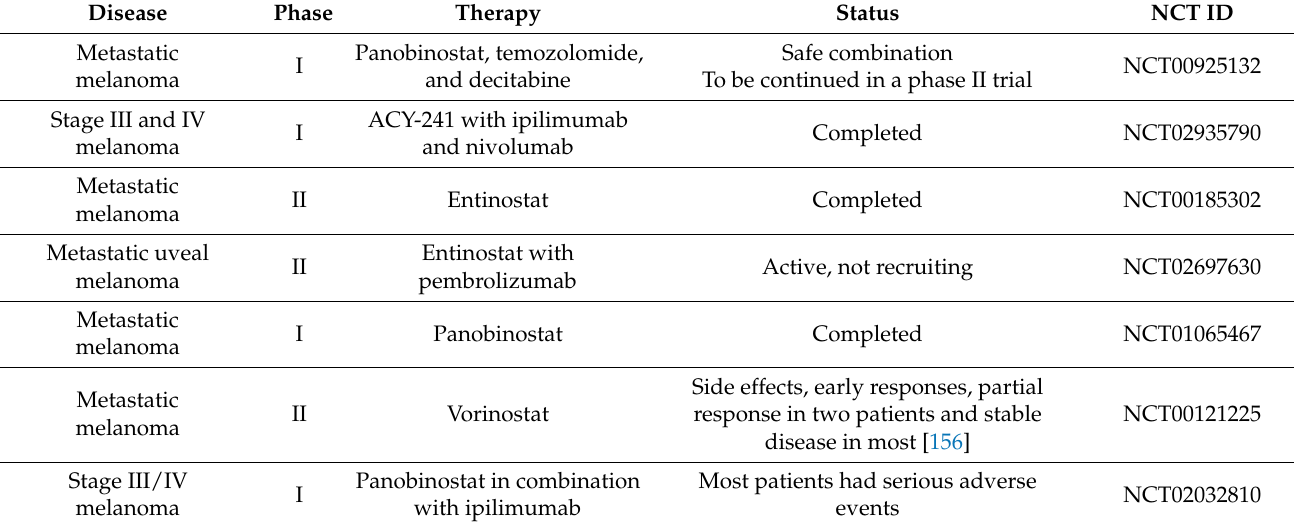
Table 3. List of clinical trials in melanoma combining the current therapies with epigenetic modifiers.